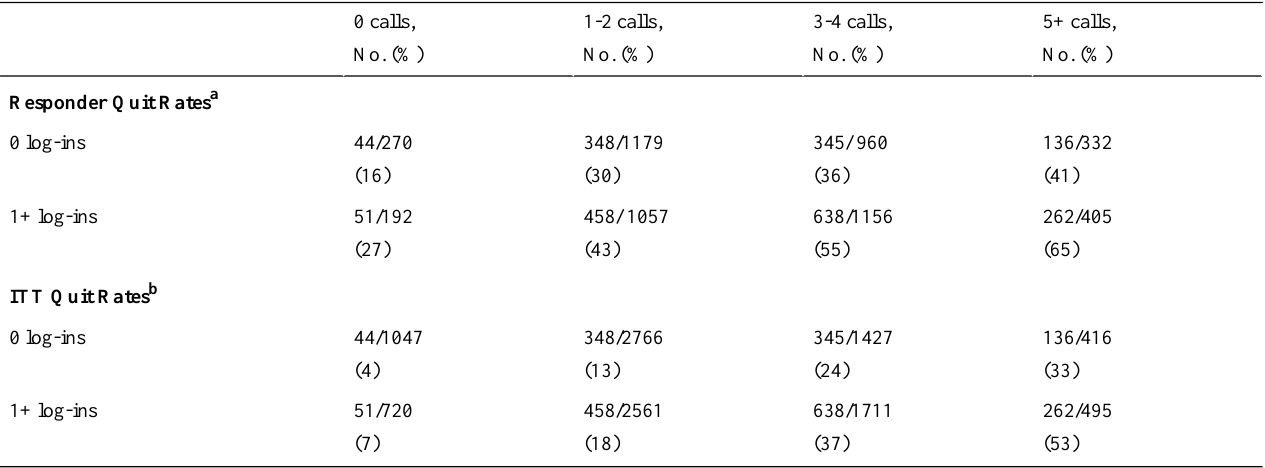
Table 5. Quit rates (responder and ITT), by call level and dichotomous log-in